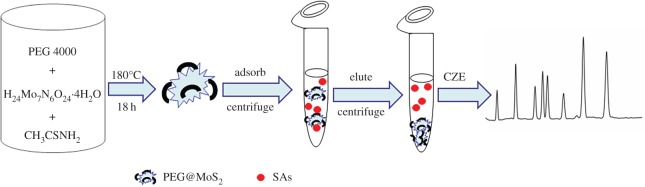
The flow chart of the synthesis of PEG@MoS2 and its application in the determination of SAs by DSPE-CZE.